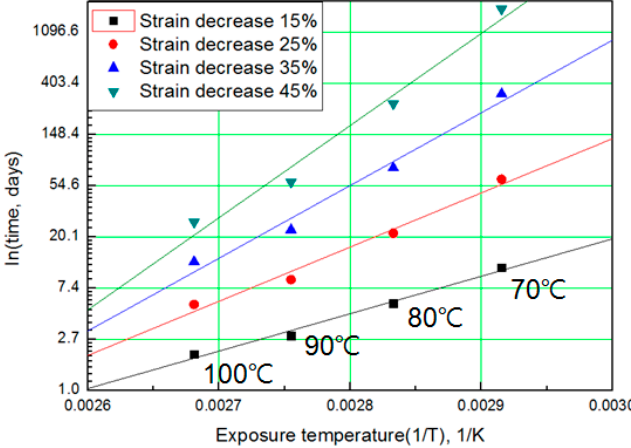
Figure 11. Arrhenius plot according to characteristic values.